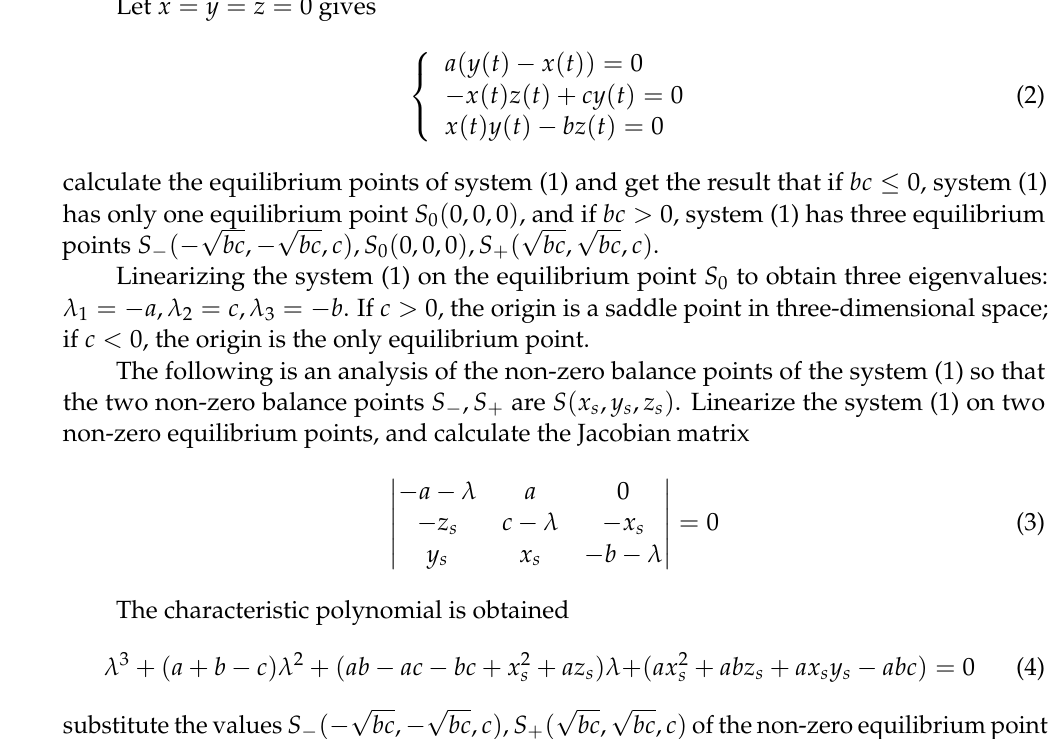
Figure 2. Time course diagram. ( a ) Original x ; ( b ) after adding perturbation x 1 ; ( c ) difference plot x 1 - x .